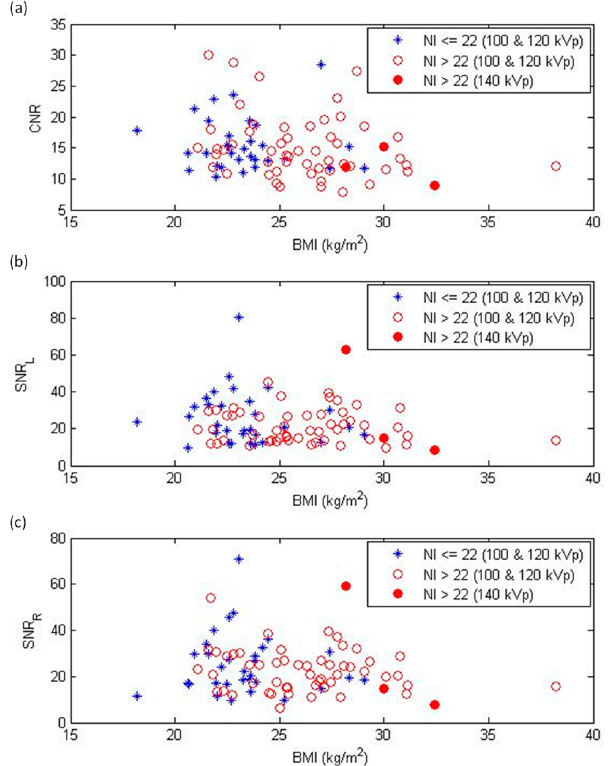
Figure 5. Objective image quality expressed in terms of ( a ) contrast-to-noise ratio (CNR), ( b ) signal-to-noise ratio of left coronary artery (SNR L ), and ( c ) signal-to-noise ratio of right coronary artery (SNR R ) as functions of body mass index (BMI). NI = noise index.